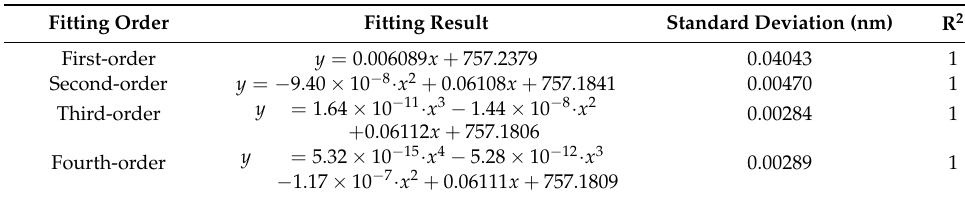
Table 11. Fitting results of the corresponding relationship between the center wavelength of the water vapor absorption band observation channel (channel 4) and the PBSC.